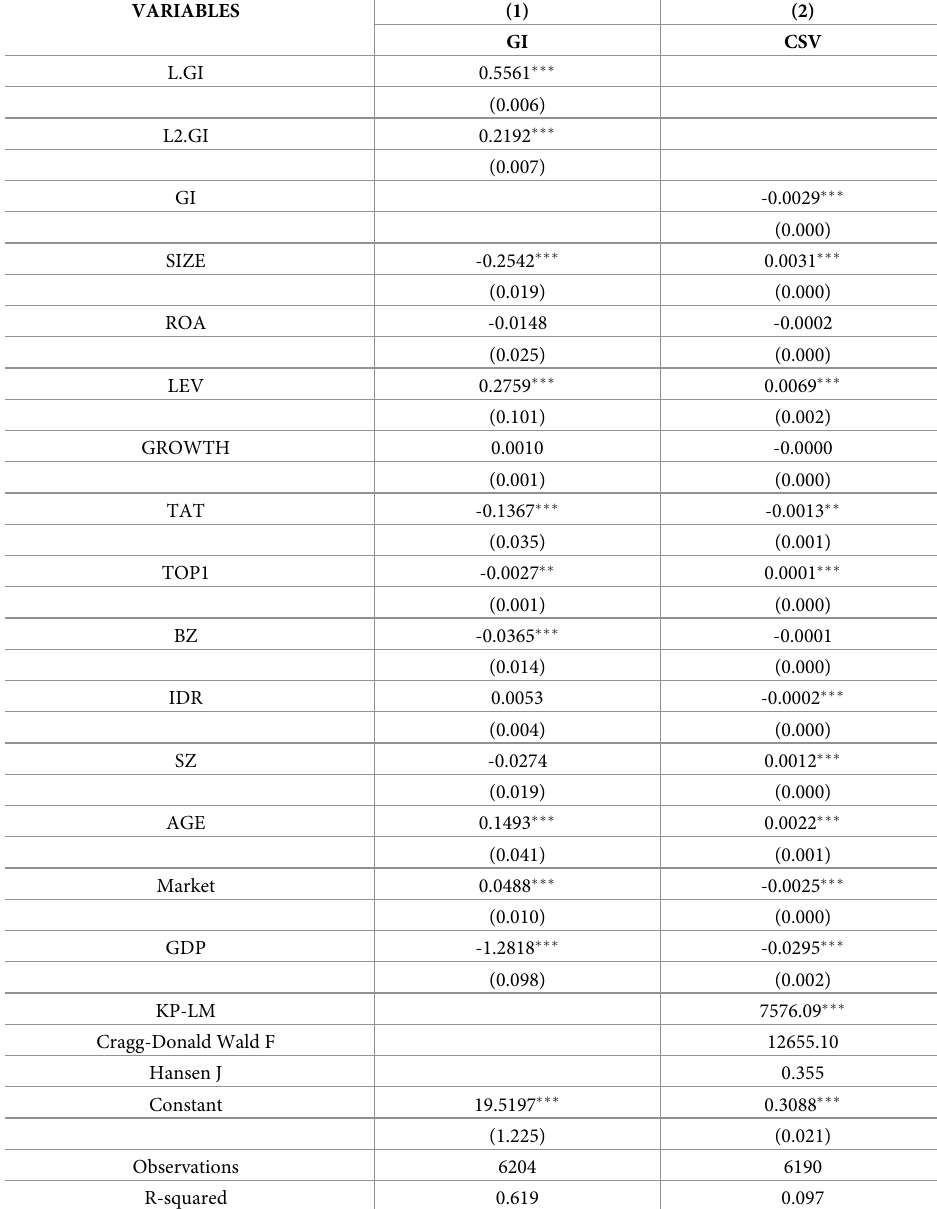
Table 7. Tool variable regression